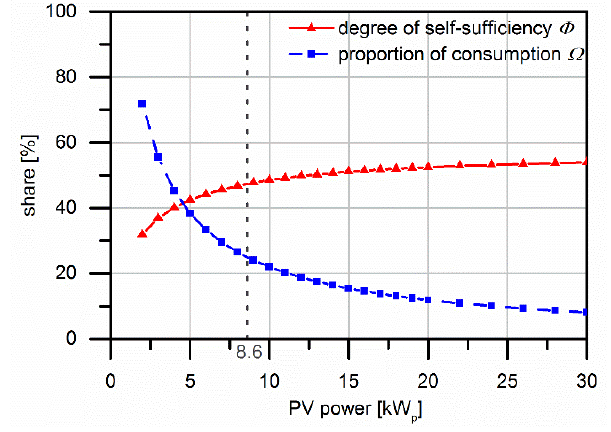
Figure 6. Degree of self-sufficiency and proportion of consumption dependent on PV system